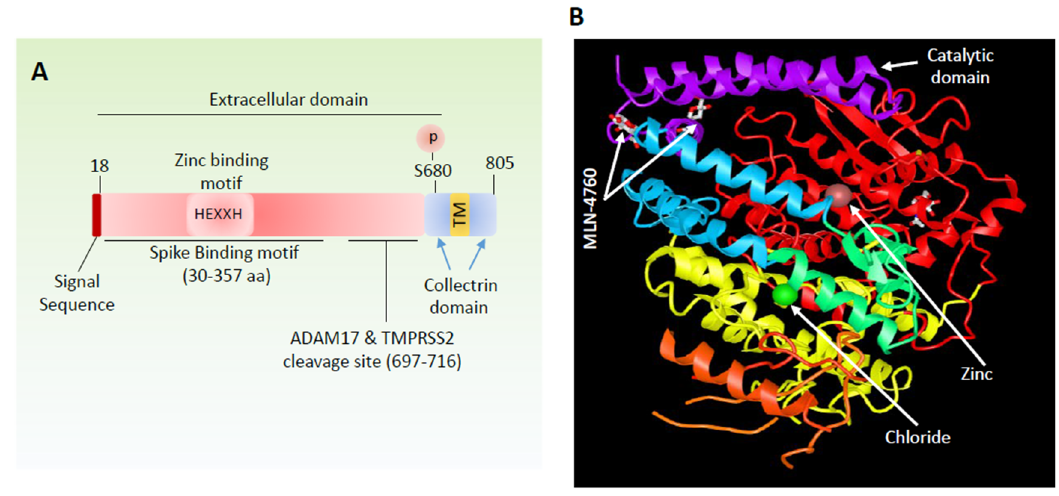
Figure 2. Schematic and domain structure of angiotensin-converting enzyme 2 (ACE2). ( A ) General domain information including, ion binding, proteolytic cleavage sites and S protein binding motif are shown. ( B ) Crystal structure of ACE2 and location of ion bindings and catalytic domain in complex with ACE2 inhibitor, MLN-476, is shown.